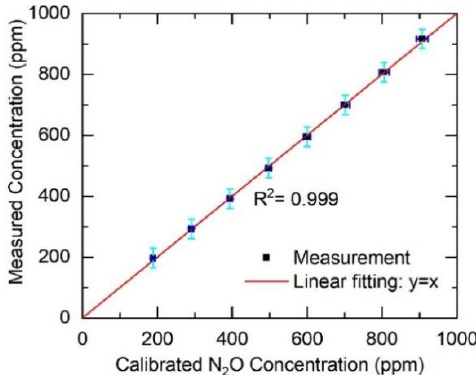
Figure 4. Comparison of the measured N 2 O concentration using HPSDS with the nominal concentration determined by the gas dilution system.